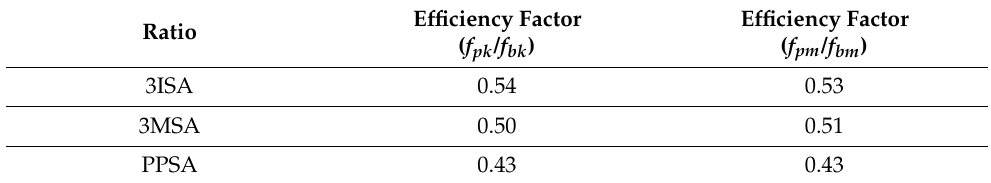
Table 5. Efficiency factor–prisms.